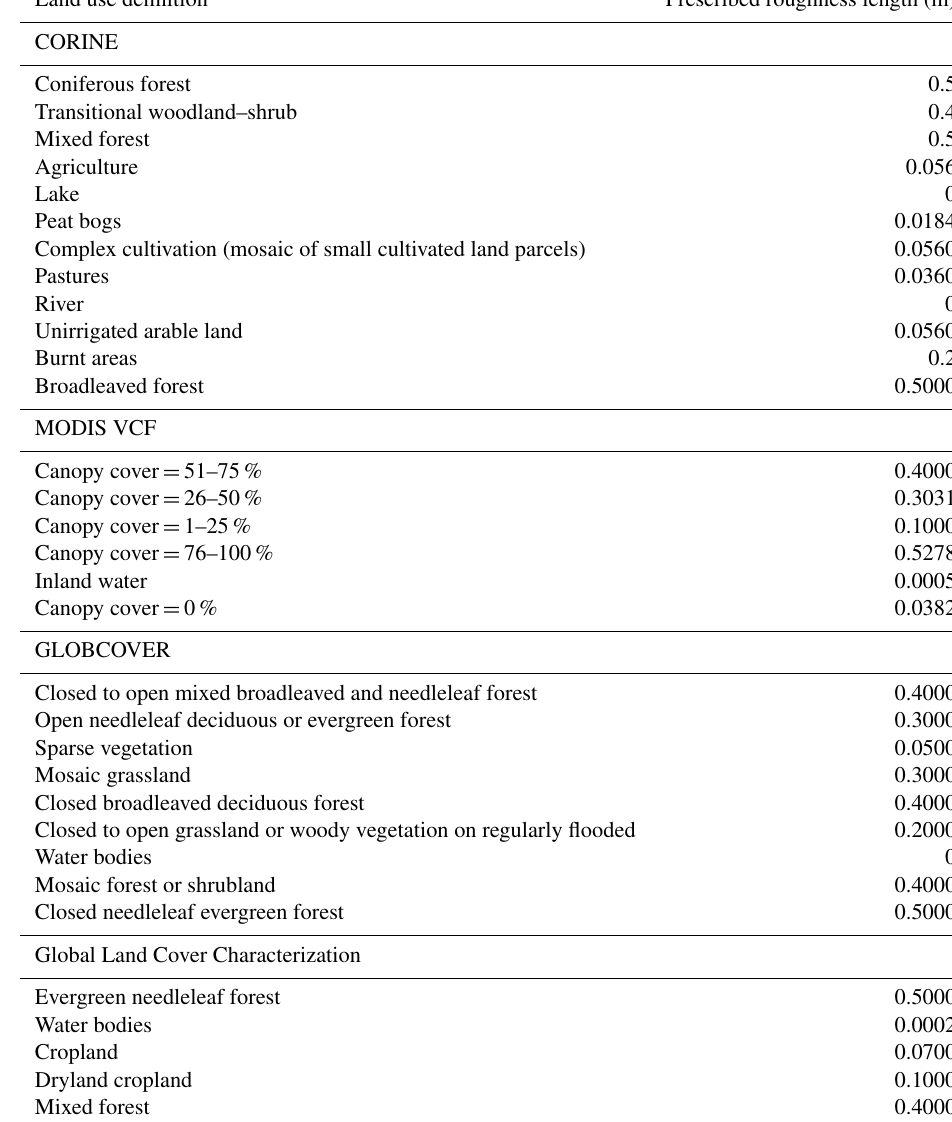
Table 3. Land use category and prescribed values of roughness length for each land use dataset. Land use